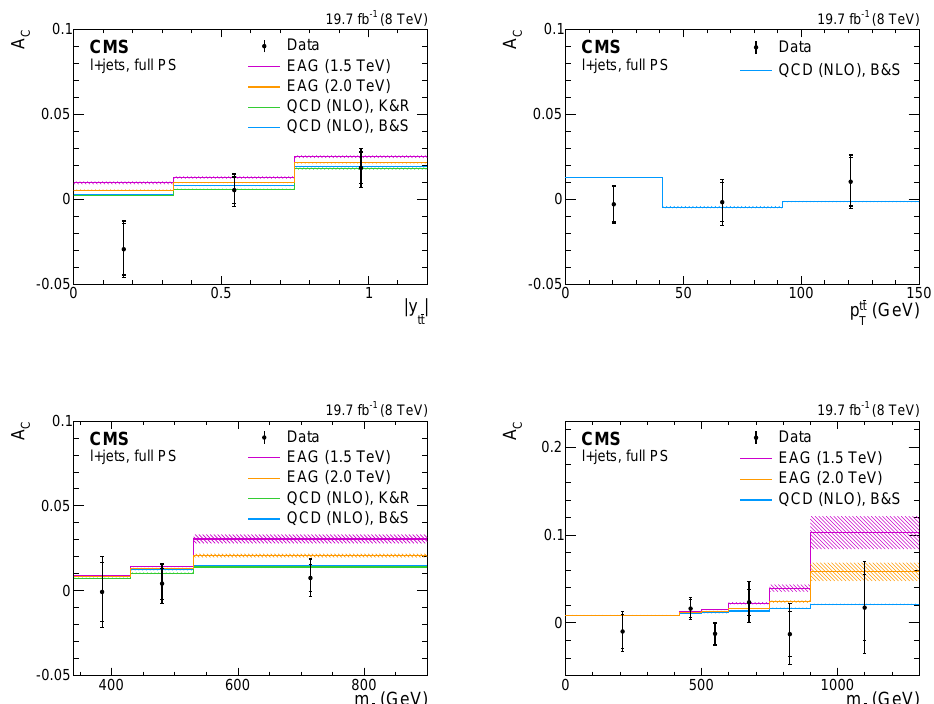
| , and p t ¯ t [50] compared with t ¯ t T